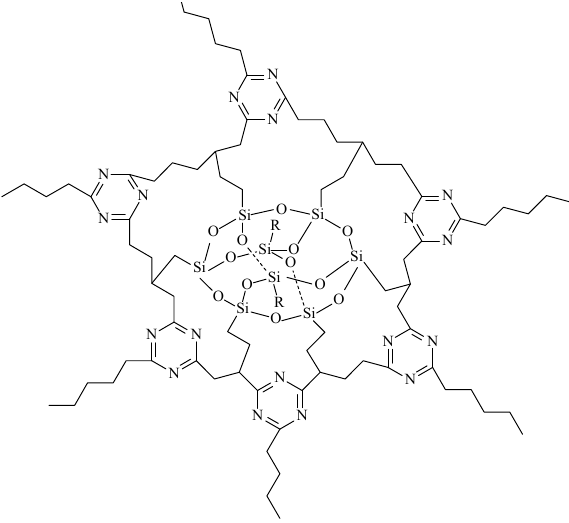
Figure 7. Possible structure of POSS in the triazine ring network.